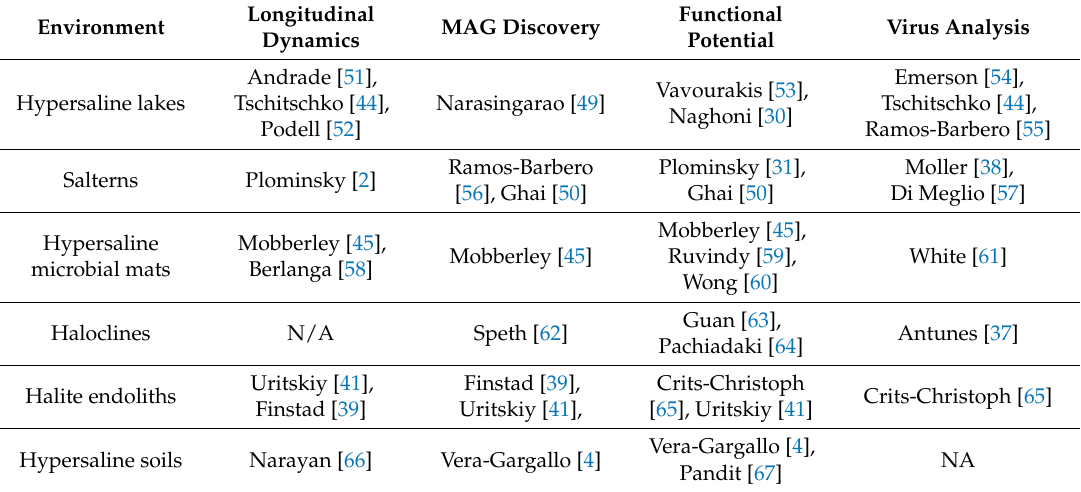
Table 1. Studies that have contributed novel aspects of halophilic microbial communities through whole-metagenomic sequencing (WMGS) in hypersaline environments (list is not exhaustive). MAG: metagenome-assembled